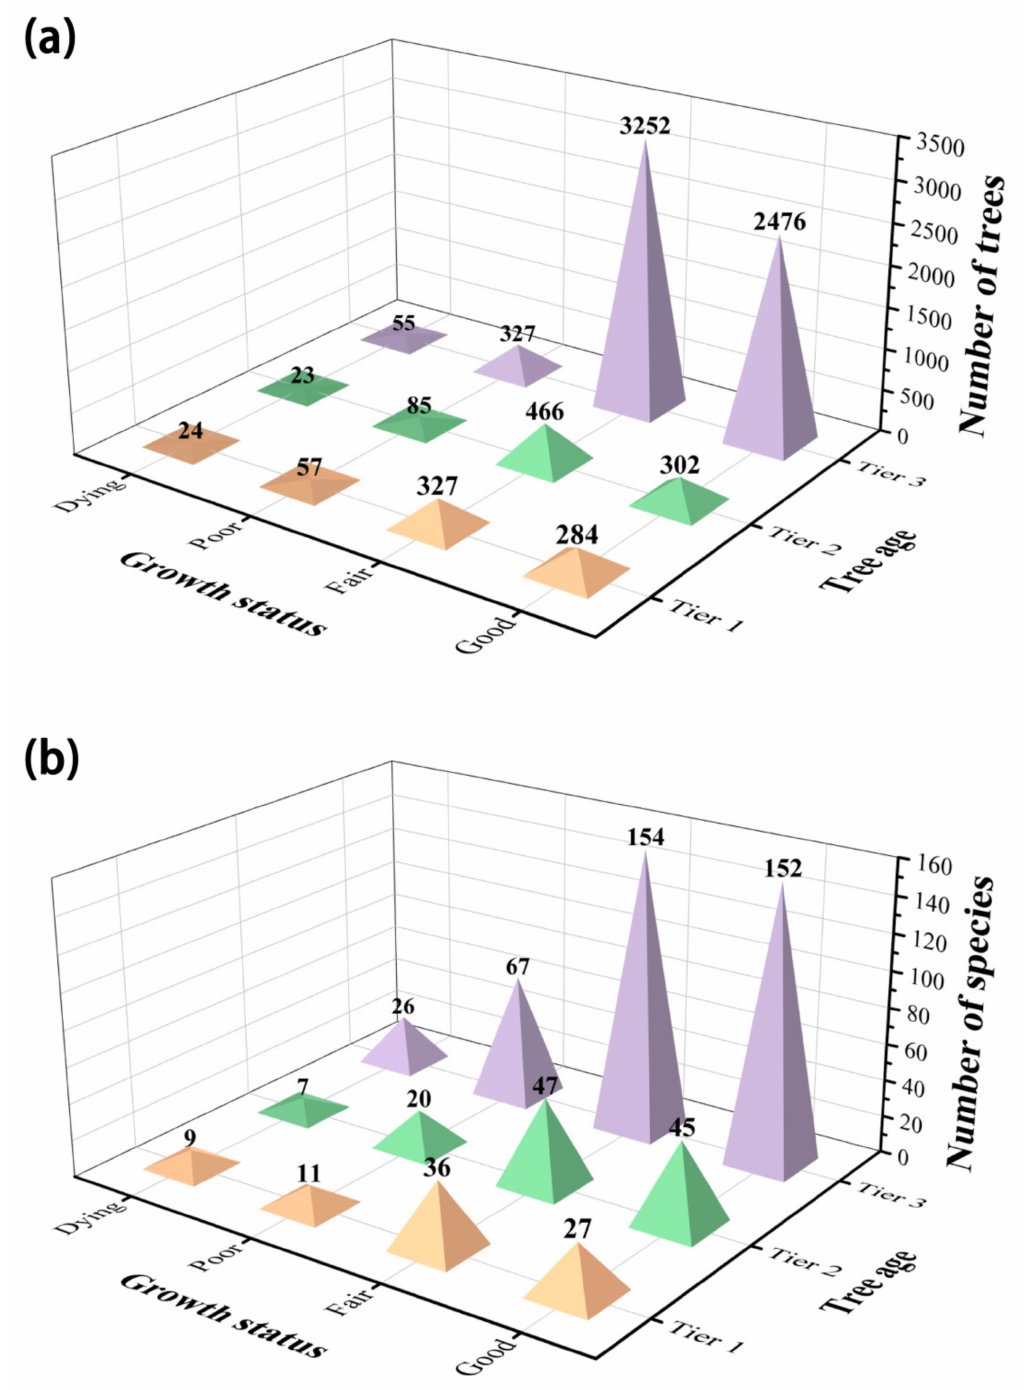
Figure 2. The counts and species of heritage trees in Jiangsu Province, eastern China: ( a ) number of trees; ( b ) number of species across four growth status and three tree